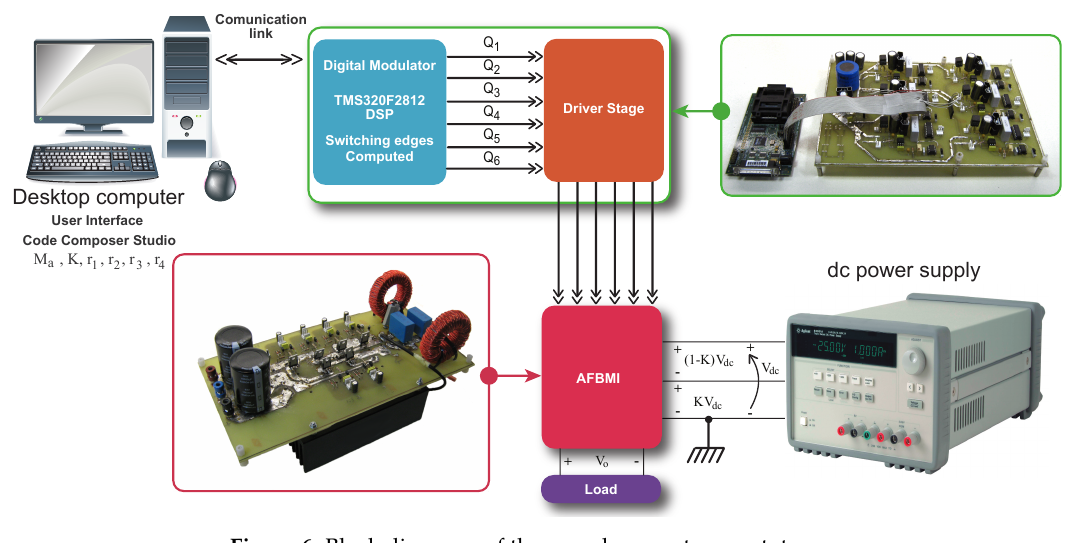
Figure 6. Block diagrams of the open loop system prototype. Table 5. Switching states and voltage